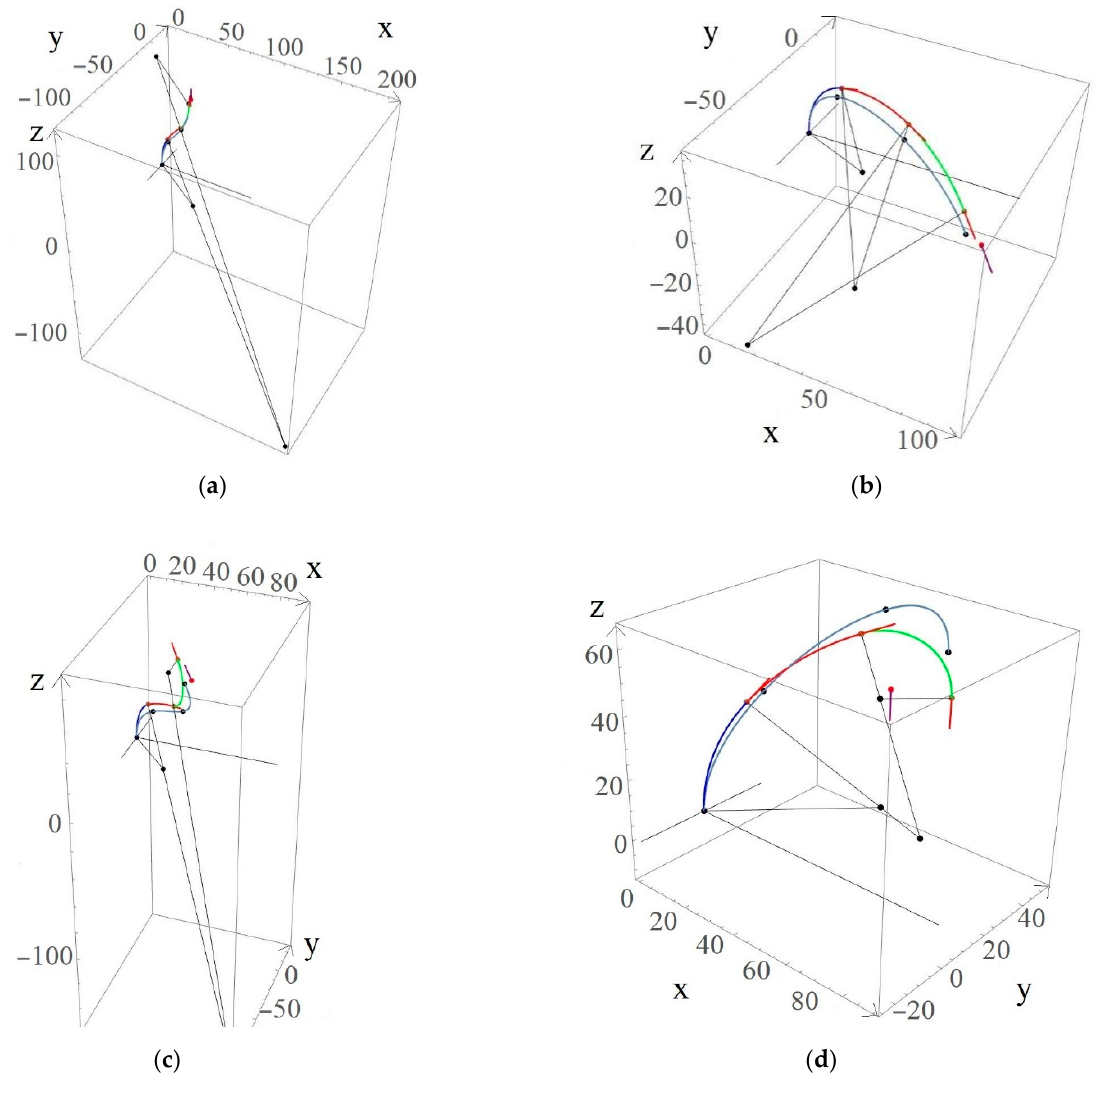
Figure 21. Bent spine views with different endpoint direction unit vector (cid:1815)(cid:3549) (cid:2928) (purple vector) and (cid:1833) goal point (redpoint) coordinates’ representation. The light blue curve is an estimated robot spine curve, and calculated robot segments arc curves are in blue, red, and green: ( a ) robot spine view when (cid:1833) = (50, −33,100) and (cid:1815)(cid:3549) (cid:2928) = (0, 0, 1) ; ( b ) robot spine view when (cid:1833) = (94, −54,20) and (cid:1815)(cid:3549) (cid:2928) = (0.6509,−0.6509, −0.3906) ; ( c ) robot spine view when (cid:1833) = (55, −55,80) and (cid:1815)(cid:3549) (cid:2928) =